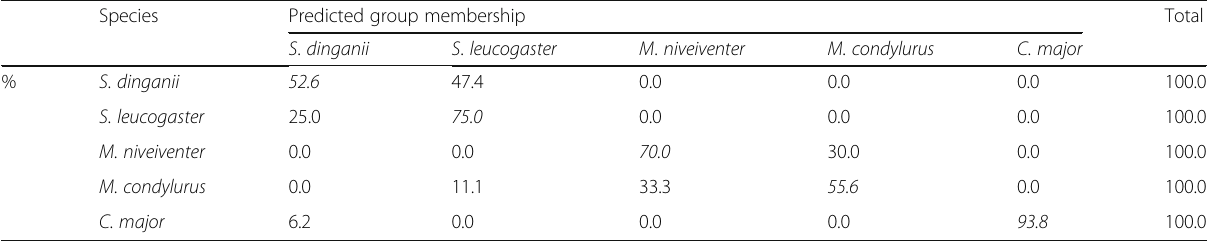
Table 5 Classification table showing the percentage of calls correctly classified into species groups Species Predicted group membership